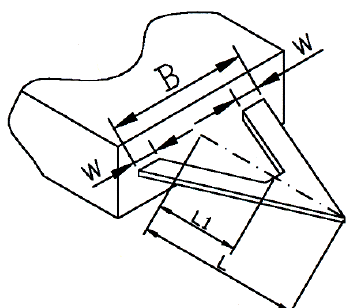
Figure 4. V-shaped cantilever parameters: L is the length, L w are the width